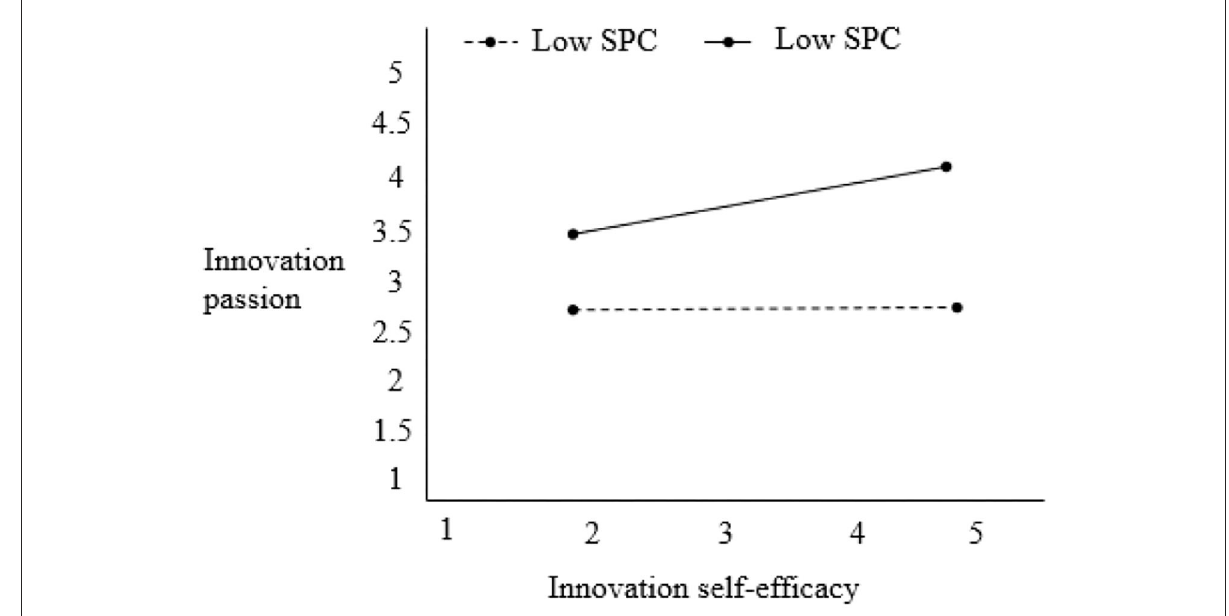
FIGURE2 Regulating effect of the innovation climate based on